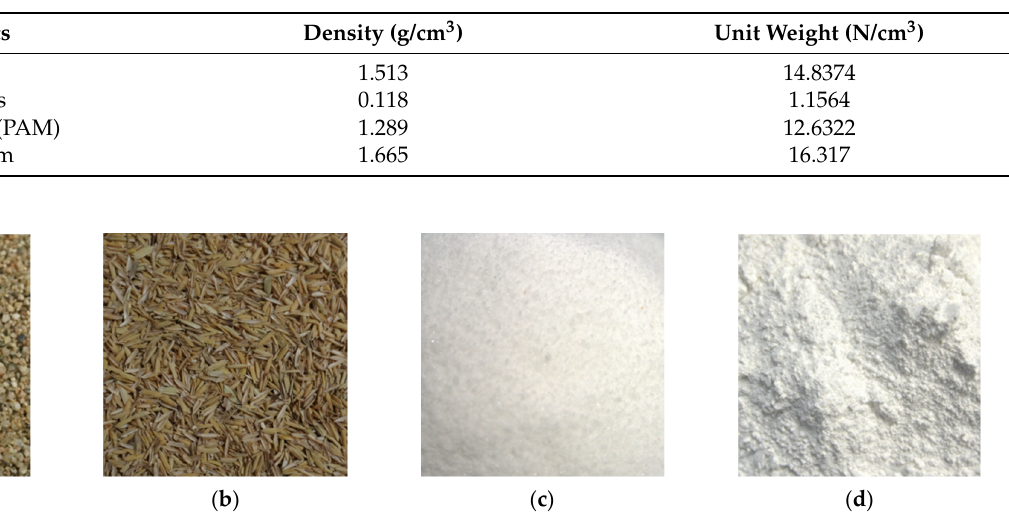
Table 2. Physical properties of different modified materials.